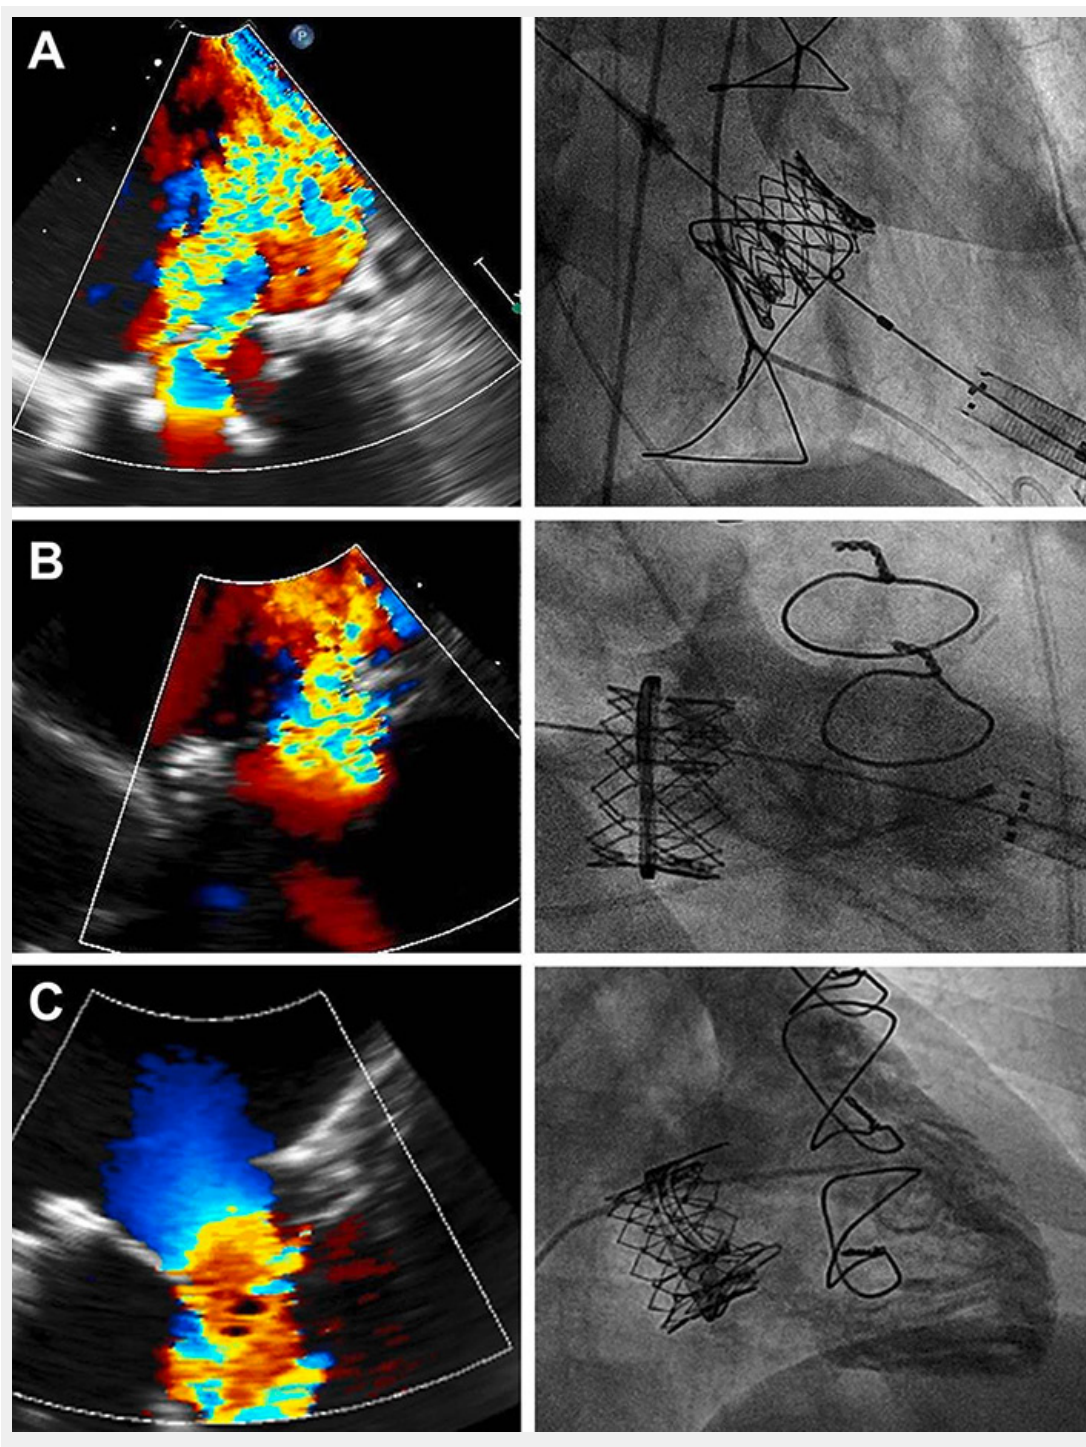
Examples of off-label use of TAVI devices. Selected examples of off-label use of transcatheter aortic valve implntation devices. A: valve-in-valve implantation (29 mm Edwards Sapien XT) for treatment of severe mitral regurgitation in a 88-year-old male 12 years after surgical mitral valve replacement (Medtronic Mosaic 33 mm); B: valve-in-ring implantation (26 mm Edwards Sapien XT) for treatment of recurrent severe mitral regurgitation in a 83-year-old female patient 3 years after mitral valve repair with a semi-rigid 30 mm Edwards Physio II ring; C: transfemoral tricuspid valve-in-valve implantation in a young women (41 years old) known for Ebstein anomaly and presenting with severe symptomatic tricuspid stenosis due to leaflet fusion 6 years after surgical tricuspid valve replacement (Edwards Perimount Magna 33